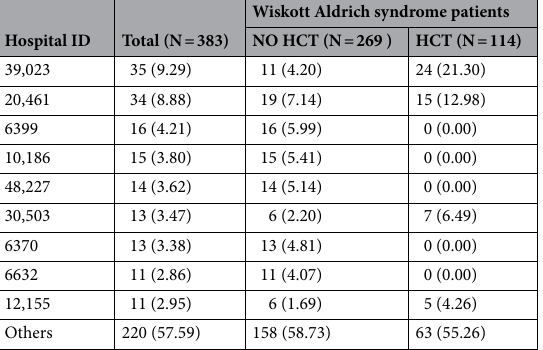
Table 3. Distribution of hospitalizations among different hospitals in the country. 76 Hospitals were categorized as Others as none of them had more than 7 patients